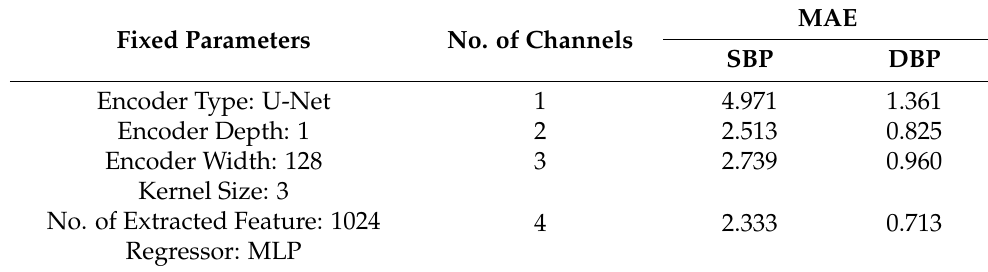
Table 6. MAE of BP prediction for variable channels.